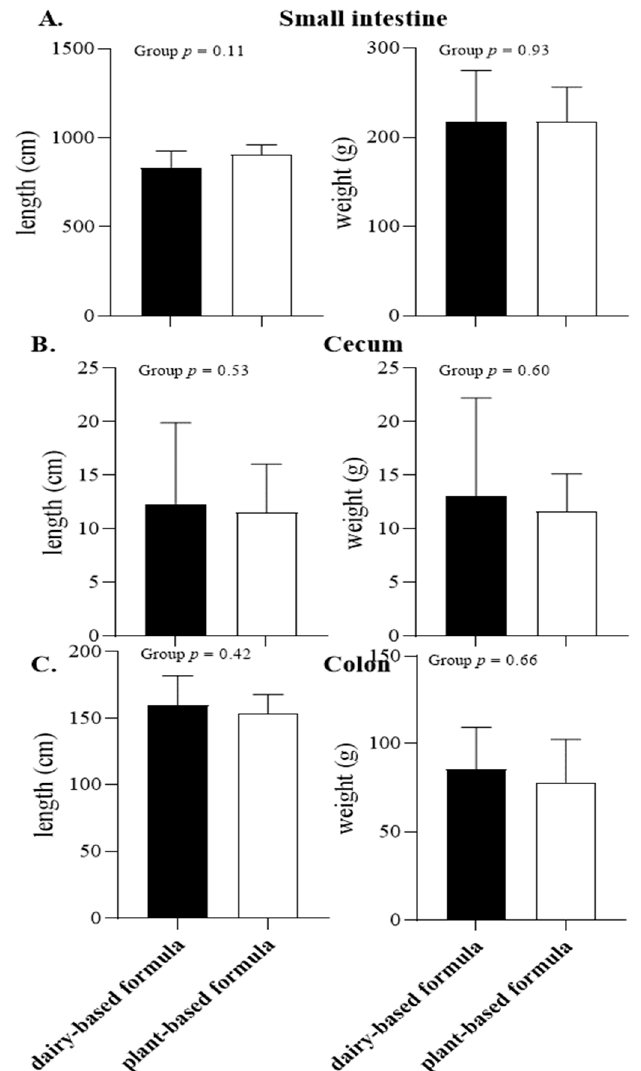
Figure 3. Absolute length (cm) and organ weight (g) of small intestine ( A ), cecum ( B ), and colon ( C ) of 21-day-old piglets fed either a dairy-based (Similac Advance powder) or a plant-based (Else nutrition powder) formula ( n = 9/group) from postnatal day (PND) 2 until PND 21. Table 2. Organ weights (g) of neonatal piglets at 21 days of age fed either a dairy-based or a plant- based formula. Data are presented as mean ± standard deviation (SD).